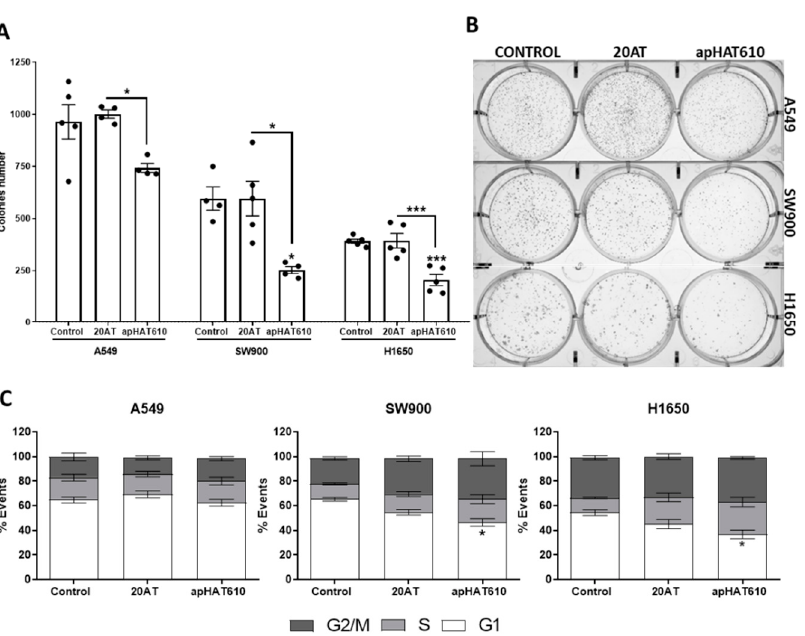
Figure 6. Effect of apHAT610 on the clonogenic capacity and cell cycle in lung tumor cell lines. ( A ) A549, SW900, and H1650 cells were seeded on p6 at density 5 × 10 5 cells/well and transfected at 24 h with apHAT610 at previously established working concentrations. After 24 h, cells were counted and seeded in p6 at 1000 cells/well for all three lines. The graph represents the mean ± SEM of five independent experiments (* p < 0.05 relative to control or relative to 20AT; *** p < 0.001 relative to control). ( B ) Representative image of the colonies. ( C ) Cells were seeded at a density of 5 × 10 5 cells/well in p6, and 24 h later transfected with the apHAT610 aptamer at a concentration of two times the IC50. After 24 h, cells were fixed, stained with propidium iodide, and analyzed by cytometry. Graphs represent the means ± SEM of five independent experiments (* p < 0.05 relative to control).